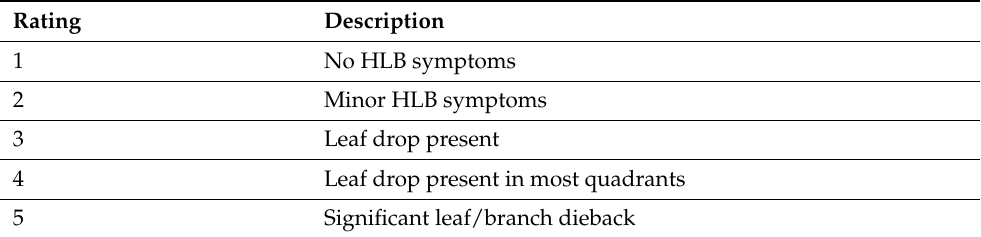
Table 1. Visual huanglongbing (HLB) rating system. Each canopy hemisphere is subdivided into four equal quadrants by two imaginary perpendicular planes (vertical and horizontal at mid canopy height) passing through the axis of the tree trunk. The resulting eight sections are scored individually on a 0–5 scale indicative of the proportion of limbs expressing HLB disease symptoms within each